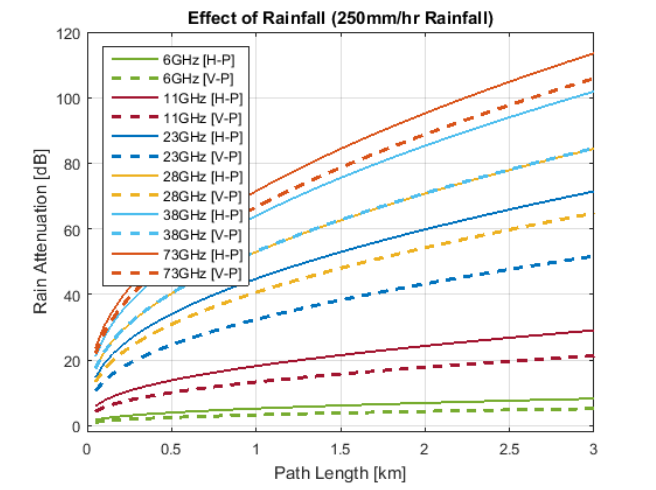
Fig 35. Effect of rainfall (3 km, 250 mm/hr)